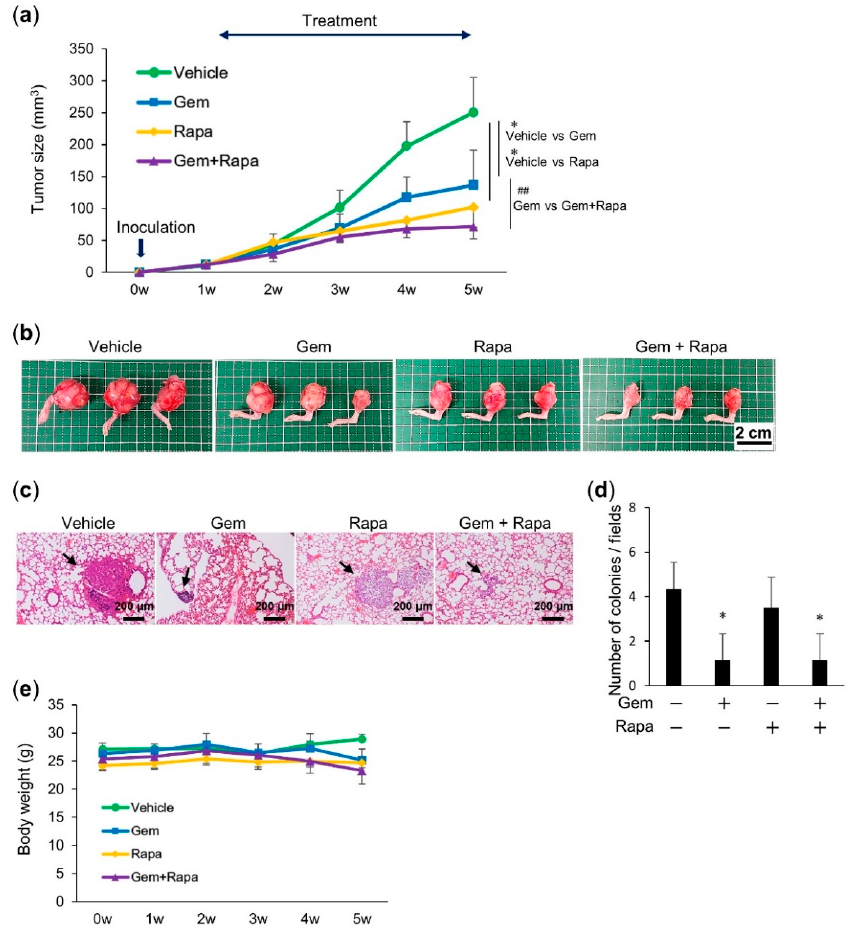
Figure 5. Combined administration of Gem and Rapa reduced the growth and metastasis of 143B cells in a murine intramedullary xenograft model. ( a ) BALB/c nu/nu mice were transplanted with 143B cells and treated with Gem, Rapa, or the combination. Tumor sizes in the mice were measured weekly. Values represent the mean ± SD ( n = 10). * p < 0.05 compared with the vehicle. ## p < 0.05 vs. Gem alone. ( b ) Representative photos of primary tumors at 5 weeks after the transplantation of 143B cells. Bar = 2 cm. At the same time, the lungs were removed and metastatic nodules were counted. ( c ) Representative micrographs of the lungs (hematoxylin–eosin staining). Arrows indicate metastatic nodules; bar = 200 μ m. ( d ) Quantitative analysis of metastatic nodules in the lungs. Results are shown as mean ± SD. * p < 0.05 compared with the vehicle. ( e ) The weights of the mice were measured weekly for 5 weeks. Data are the mean ± SD ( n = 10). See Supplementary Figure S9 for a schematic flowchart.